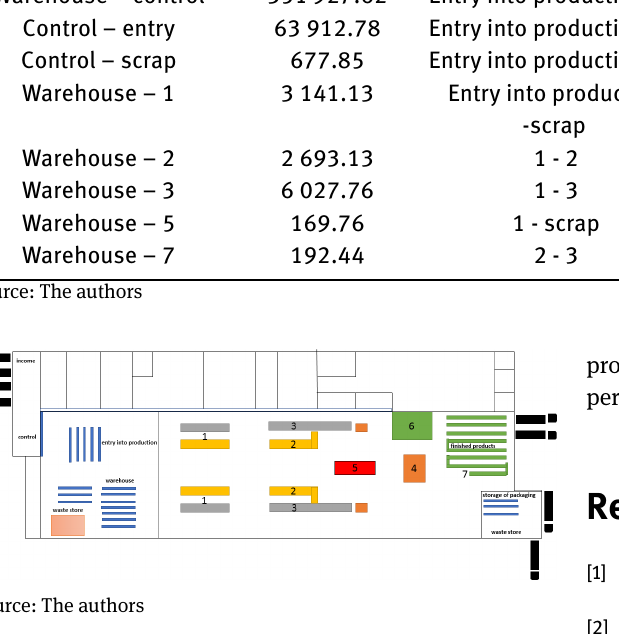
Figure 5: The new arrangement of the production processes